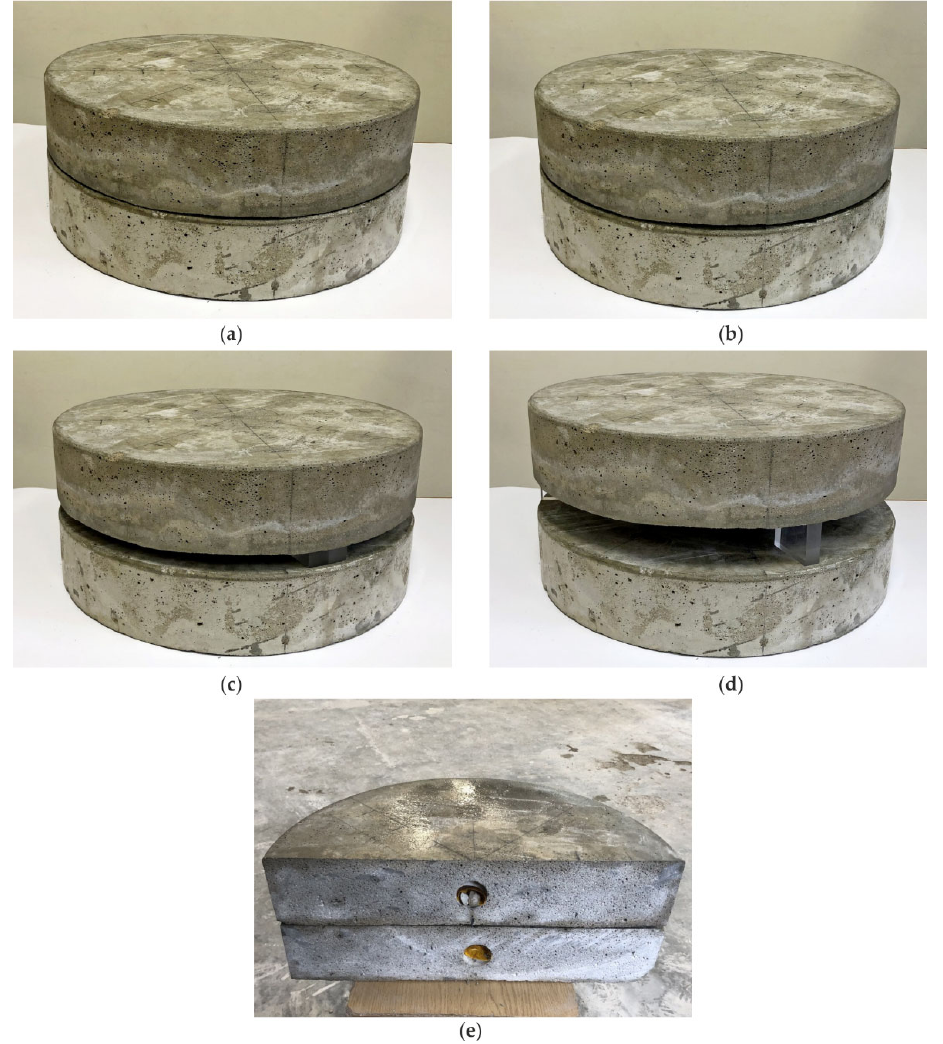
Figure 4. Circular concrete slabs with air gaps of different thickness: ( a ) 1 mm; ( b ) 4 mm; ( c ) 20 mm; ( d ) 50 mm; and ( e ) upper plate after